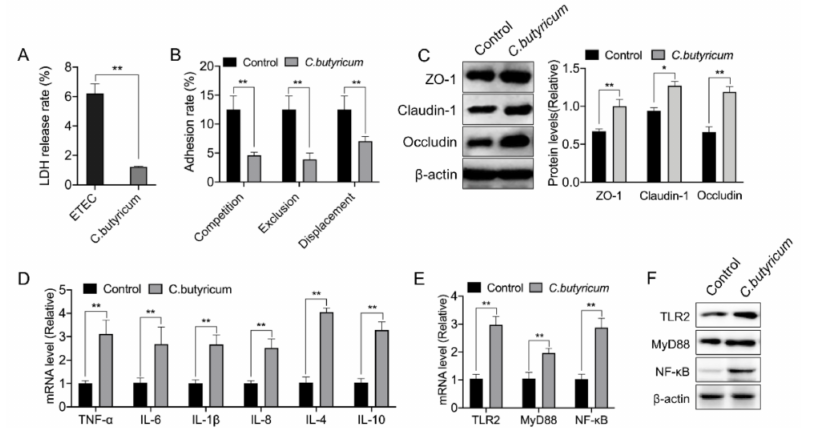
Figure 5. C. butyricum ZJU-F1 enhances the intestinal barrier function and TLR-2 signaling. ( A ) LDH release of IPEC-J2 treated with or without C. butyricum ZJU-F1. ( B ) Competition, exclusion, and displacement of ETEC K88 adhering to IPEC-J2 cells with C. butyricum . ( C ) Western blot analysis of the expression of tight junction proteins in the IPEC-J2 cells treated by C. butyricum ZJU-F1. The right panel shows the relative levels quantified by densitometry and normalized to β -actin. ( D ) qPCR analysis of the expression of cytokines, including TNF- α , IL-6, IL-1 β , IL-8, IL-4, and IL-10, in IPEC-J2 treated with C. butyricum ZJU-F1. ( E ) qRT-PCR analysis of the expression of TLR2, MyD88, and NF- κ B in the IPEC-J2 cells treated by C. butyricum ZJU-F1. ( F ) Western blot analysis of the expression of TLR2, MyD88, NF- κ B from the same sample of (E). The data are expressed as the mean ± SEM, * p < 0.05, ** p < 0.01; n = 6, biological